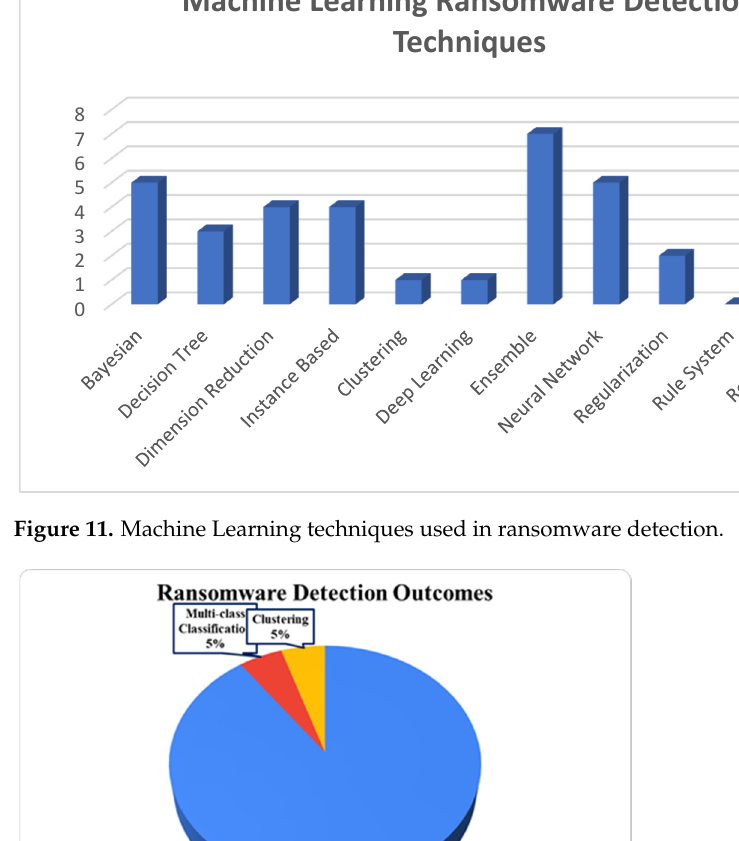
Figure 13. Ransomware Detection evaluation parameters. In [18], the authors surveyed and classified the ransomware detection tools and input information used by ransomware. Industry and academic researchers have proposed var- ious methods for detecting ransomware, all of which involve gathering information from the malware in question before it is executed (or while it is running). This data is then utilized to determine if the piece of software in question is safe or harmful. The authors provide a categorization of the data and metrics gleaned from ransomware activity. They have something to do with the many forms of ransomware. In the first level of categori- zation, they grouped over 16 parameters related to prior actions into three groupings. They distinguished static or dynamic data gathered locally from the infected machine from data gathered through the network. In the parts that follow, they examine the fol- lowing three groups: The information is locally static, meaning it is gathered prior to run- ning the malware program by extracting it. Second, data is gathered locally in real-time as the malware operates on the infected machine. Thirdly, information is gleaned through the malware’s own network activity. In Figure 14, we summarize ransomware detection tools and input information used within the scope of [18].